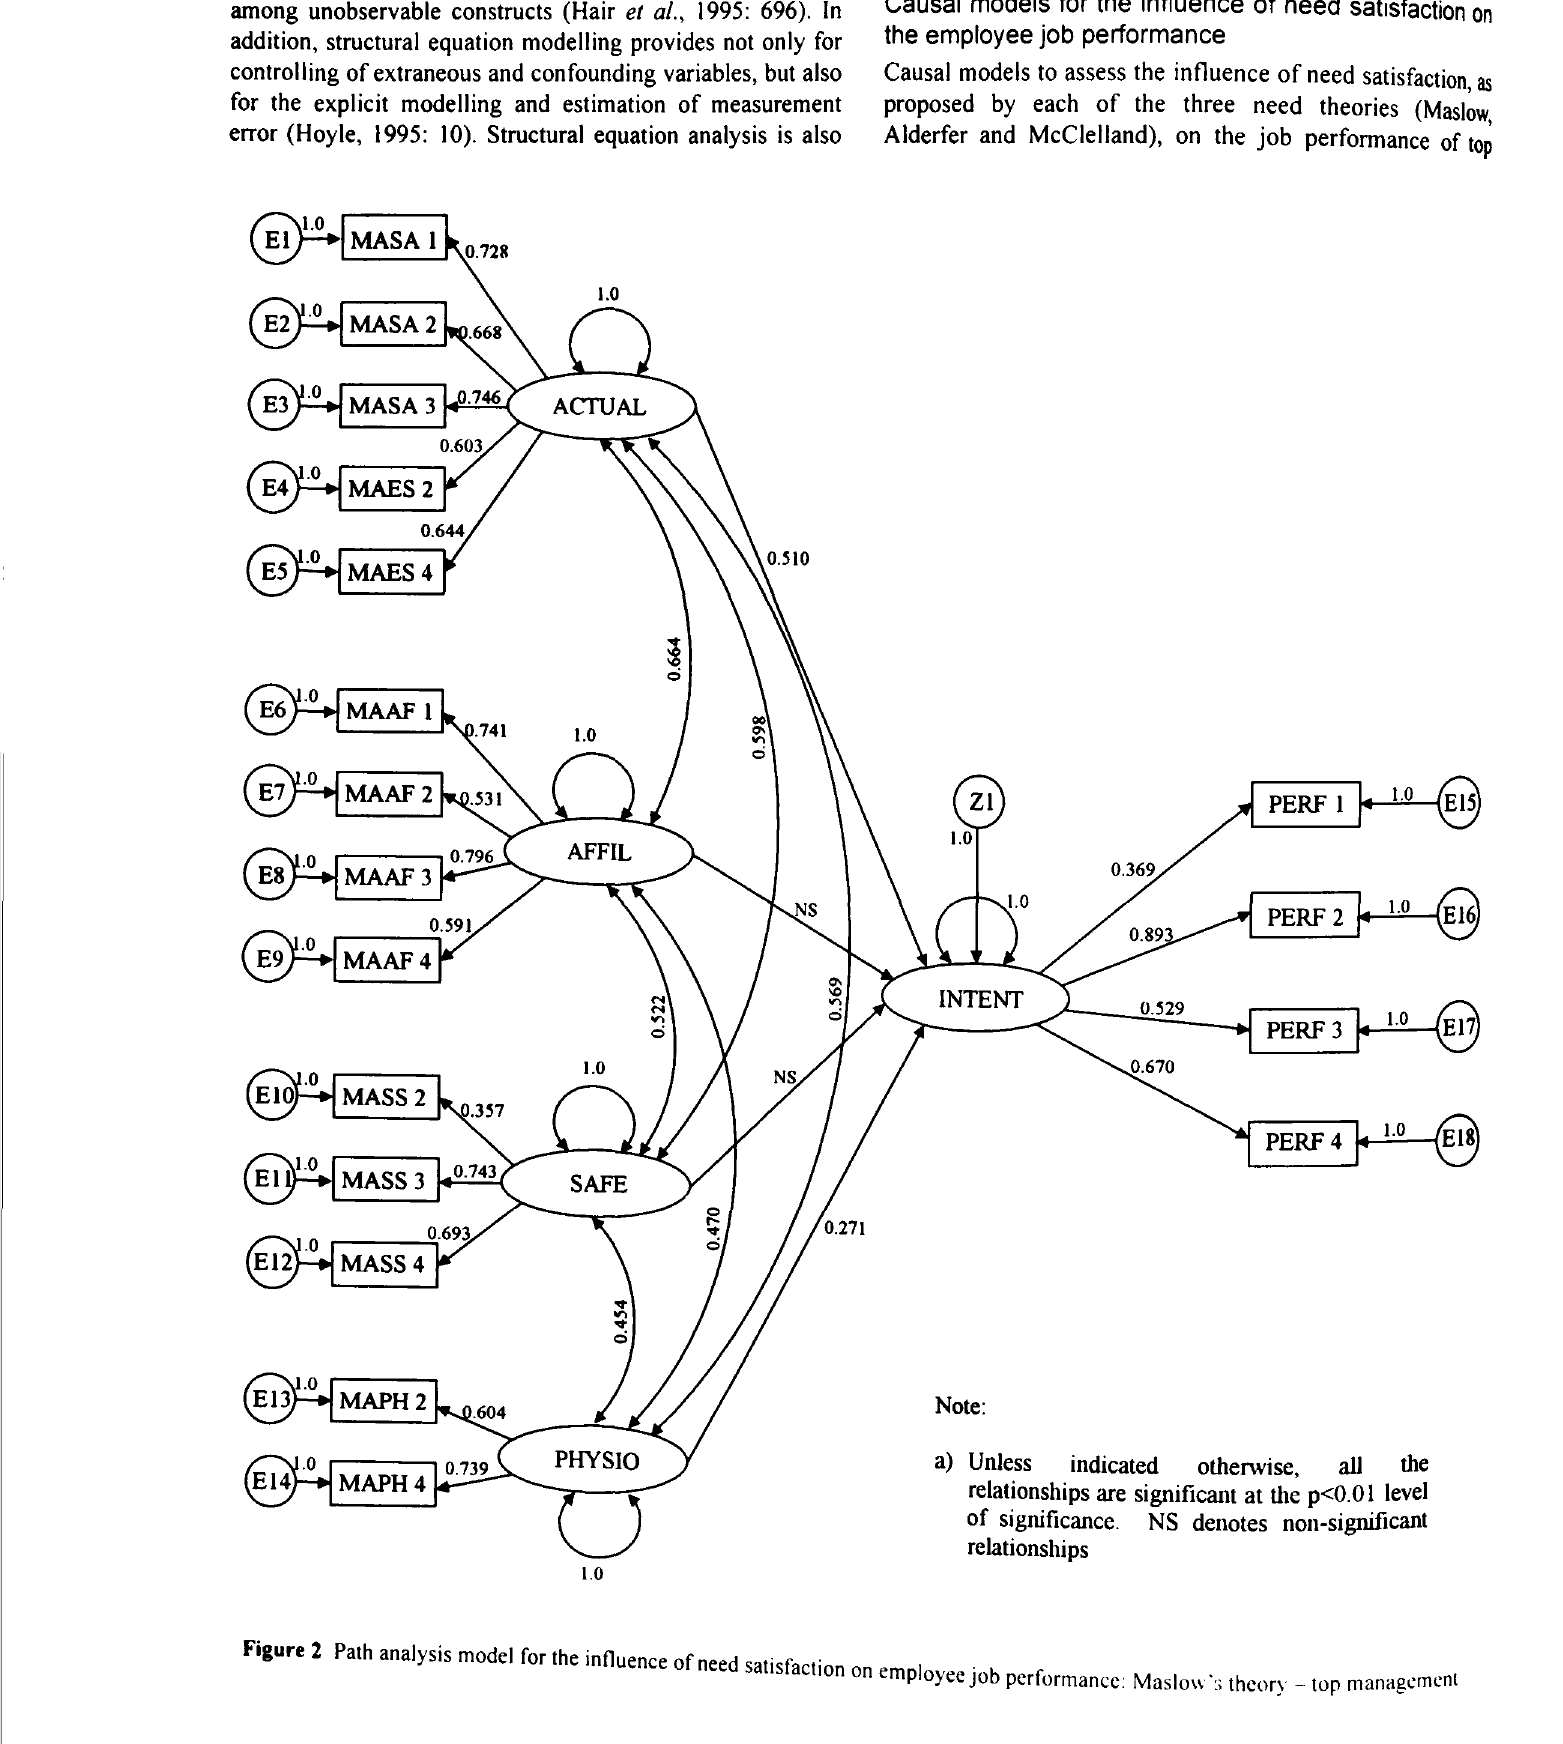
Figure 2 Path analysis model for the influence of need satisfact" I . ion on ernp oyeeJob performance: Maslow\ theory - top